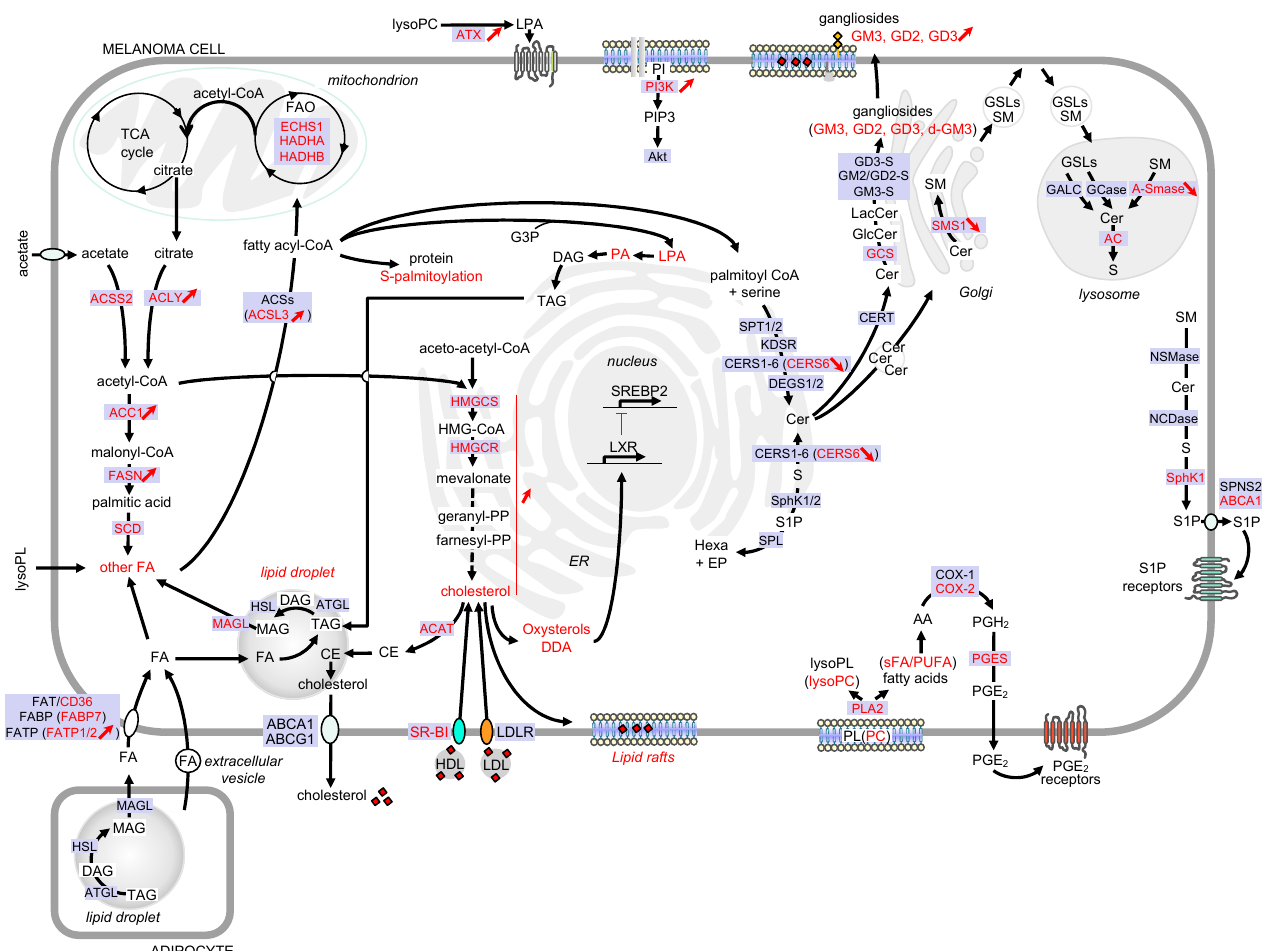
Figure 2. Detailed view of the major alterations of lipid storage and metabolism pathways during melanoma development. Only lipid pathways with reported modifications in melanoma are represented. Enzymes, receptors and transporters are indicated in blue boxes. Modifications in melanoma are highlighted in